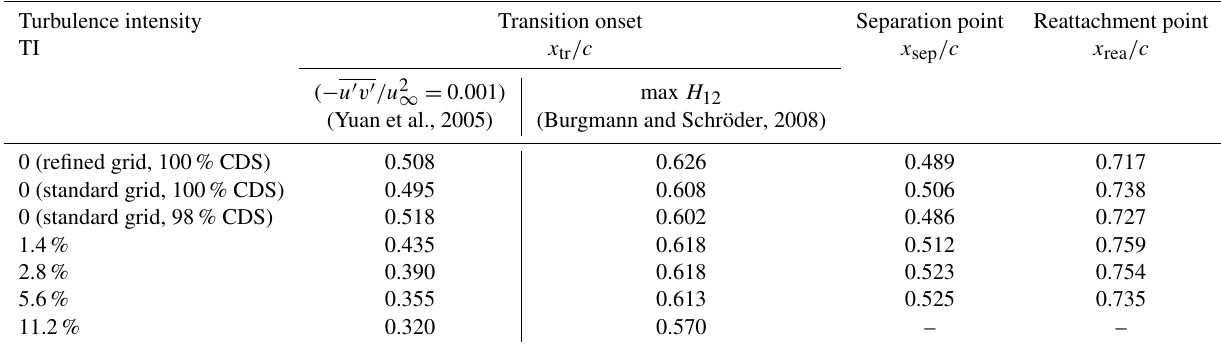
Table 3. Location of the separation and reattachment points of the averaged flow for different inflow turbulence intensities extracted at the first wall-normal cell; transition onset based on two different criteria.